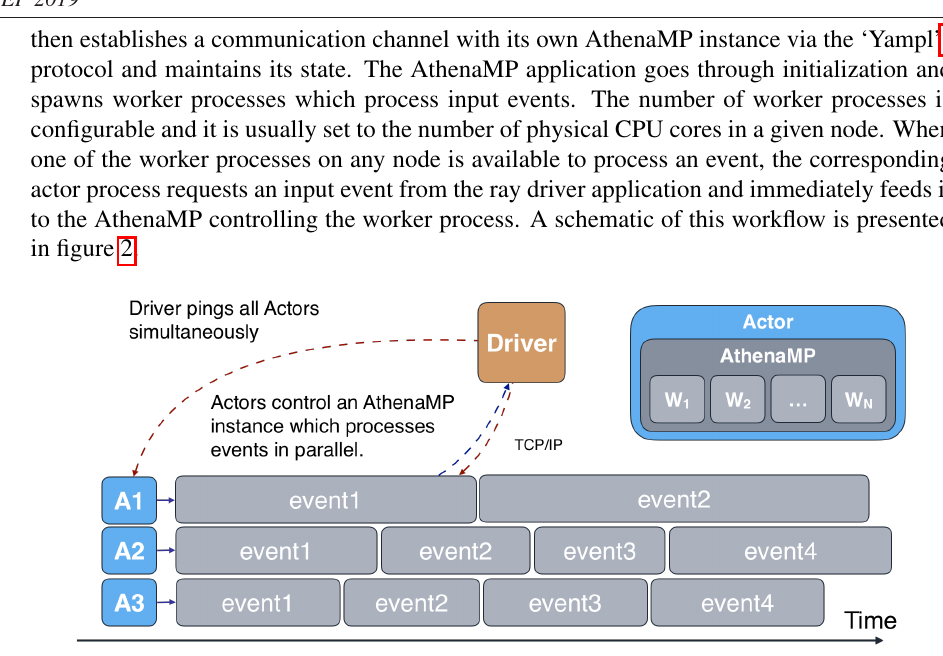
Figure 2: Schematic of Raythena. The application is designed to run on HPCs, where nodes are accessed internally through ‘login’ nodes. A single driver application (running on any node) controls the ‘Ray cluster’. Each node has one Ray Actor application which controls its own instance of an AthenaMP application. The driver application centrally feeds new events to process to available resources and maintains a TCP / IP connection between all nodes in the